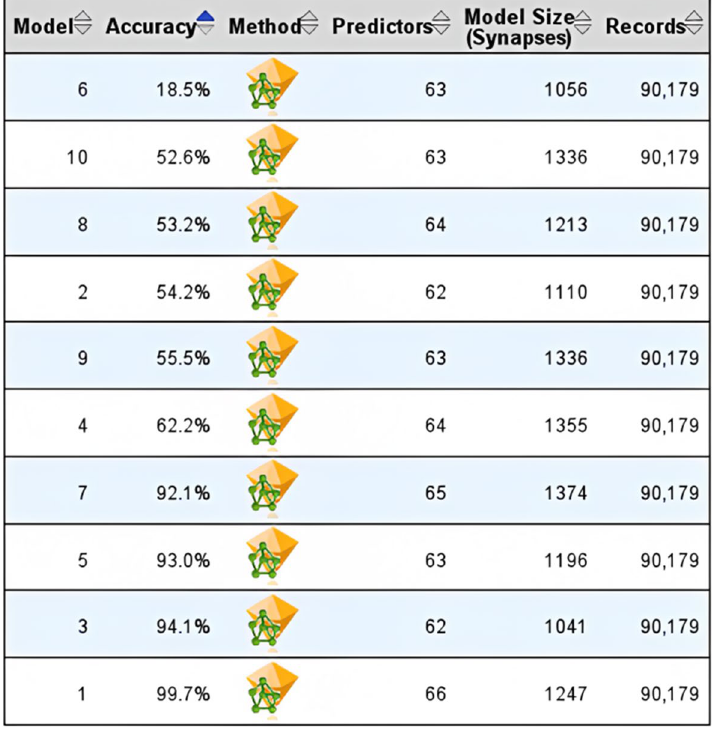
Fig. 11 Accuracy level in different